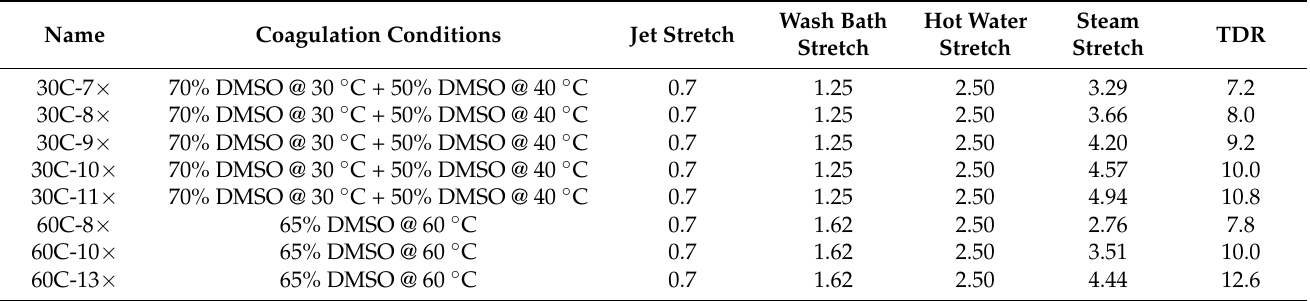
Table 1. The coagulation bath conditions, the stretching ratios at each stretching stage, and the total draw ratio (TDR) of the WFs measured in this